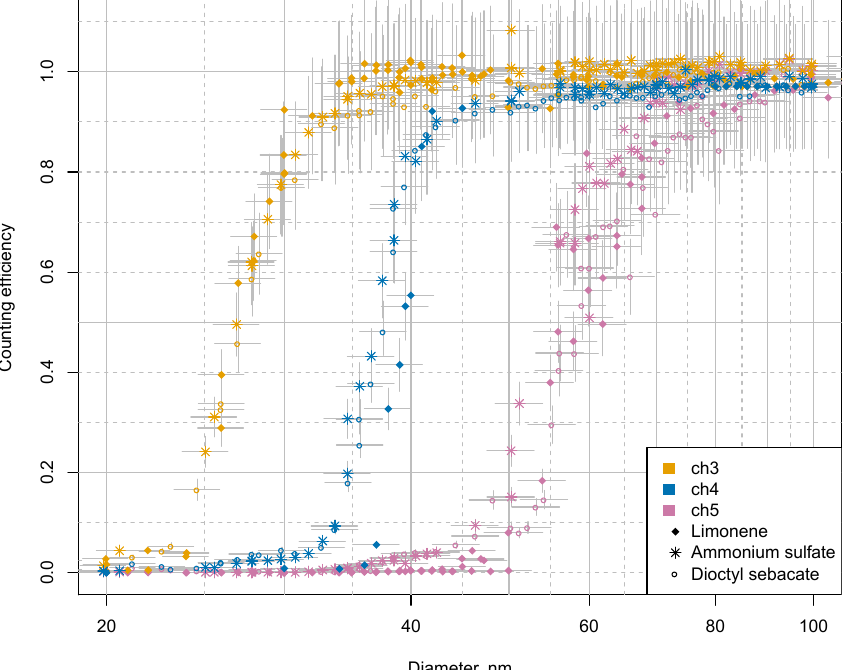
Figure 7. Counting efficiency of NMASS 1 as a function of particle diameter for particles of different chemical composition: limonene ozonolysis products (diamonds), atomized ammonium sulfate (stars), and dioctyl sebacate (circles). Only three channels are shown here because it was not possible to produce atomized particles small enough for the two channels with the smallest cut-off sizes by atomizing ammonium sulfate or dioctyl sebacate. Counting efficiencies fall with decreasing particle diameter as particles become smaller than the Kelvin activation diameter of each channel. There is no statistically significant sensitivity of counting efficiency to particle